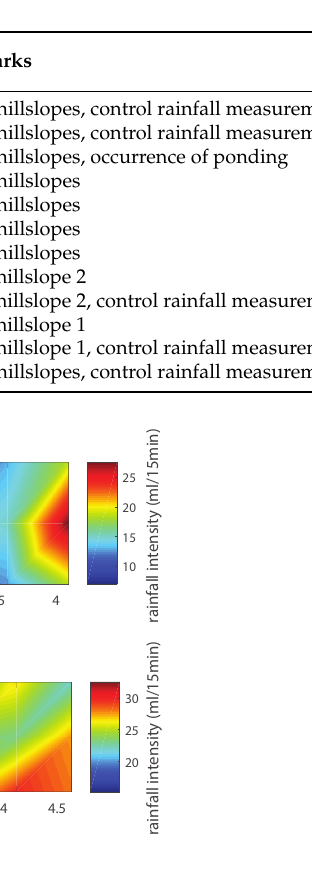
Table 3. Overview of all rainfall events.